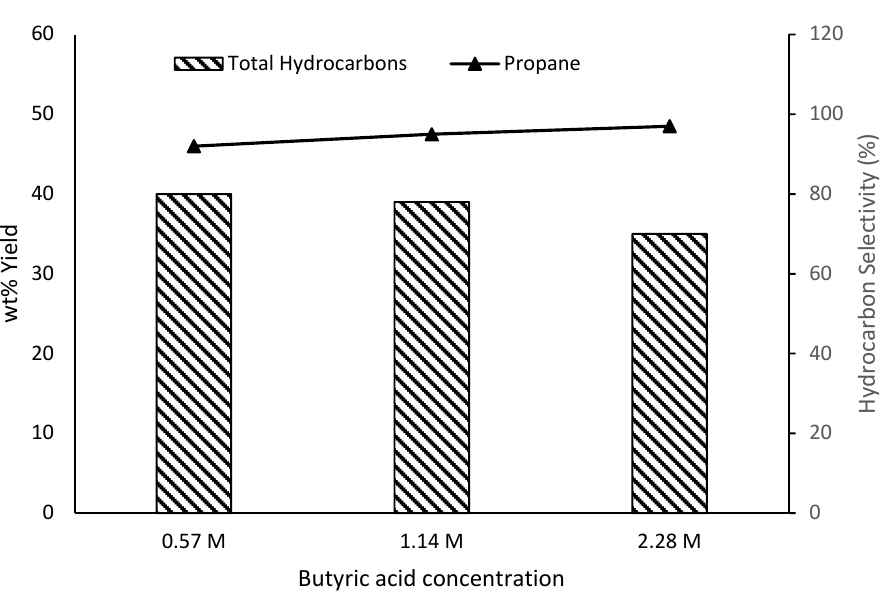
Figure 5. Effect of butyric acid loading with 0.5 g Pt/C at 300 °C after 1 h reaction time.